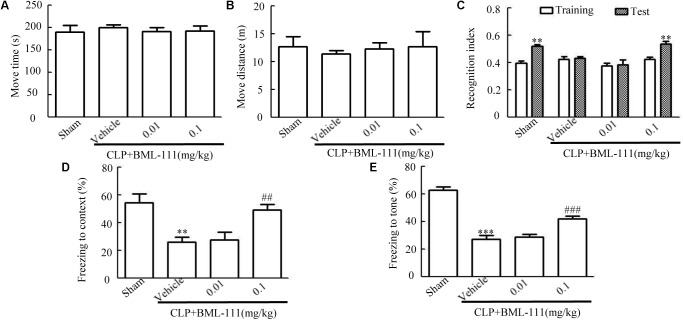
Influences of BML-111 at different doses on cognitive dysfunction in mice with sepsis. BML-111 was injected intracerebroventricularly at doses of 0.01 and 0.1 mg/kg immediately after performing CLP. (A,B) No significant difference was observed in the move time and distance parameters in the open-field test. (C–E) Effects of BML-111 at different doses on novel-object-recognition and fear-conditioning tests results. Data were shown as the means ± SEM (n = 10 surviving mice per group). ∗∗P < 0.01 represents Test vs. Training in (C). ∗∗P < 0.01, ∗∗∗P < 0.001 represent CLP + Vehicle vs. Sham and ##P < 0.01, ###P < 0.001 represents CLP + 0.1 mg/kg BML-111 vs. CLP + Vehicle in (D,E).